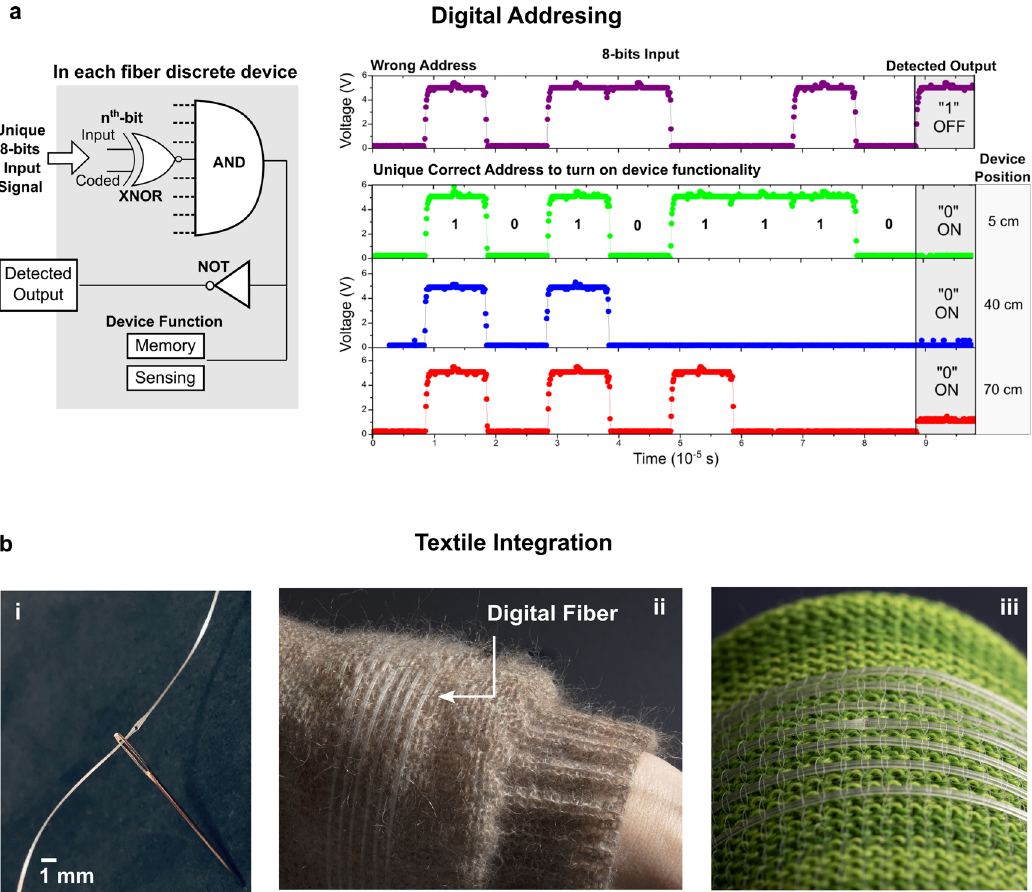
Fig. 2 Digital addressing in fi bre and textile integration. a Individual digital addressing of different devices within the fi bre. (Left) The digital circuit within each in- fi bre device which enables the device to be activated if the input 8-bit signal matches its internal coded 8-bit identi fi er address. Each bit of the 8-bit input is read by a XNOR gate (Each dotted line represents a XNOR gate). The XNOR then compares a single input bit to the stored coded bit. If it matches, the output is 1. If all XNOR-outputs to the AND gate is one, the AND-output is then a one, activating the device function and pulling the signal line down via the NOT gate. (Right) Voltage-time plots of the digital fi bre hosting multiple digital devices. Each of the devices is turned ‘ on ’ if the input matches its identi fi er address. Otherwise, the device remains ‘ OFF ’ . Note that each device is pulled up by the power line, hence the ‘ OFF ’ state is a logic one, and the ‘ ON ’ state is a logic 0. Each chip can be individually and separately controlled using its distinct digital address, allowing for spatial control of different device functions at different points along the fi bre, for instance at 5 cm, 40 cm, and 70 cm. b Integration of the digital fi bre (i) through a needle, (ii) in the sleeve of a sweater, and (iii) in a cotton-based